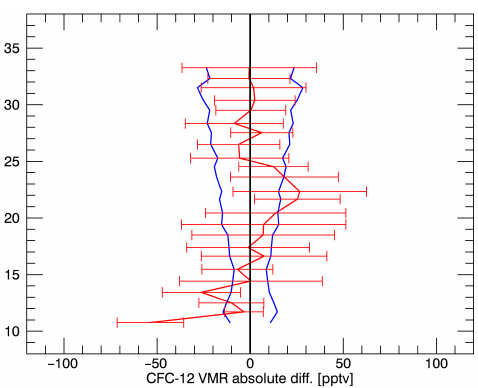
Figure 10. Same as Fig. 1, but instead of CH 4 now CFC-12. Figure 11. Same as left panel of Fig. 3, but instead of CH